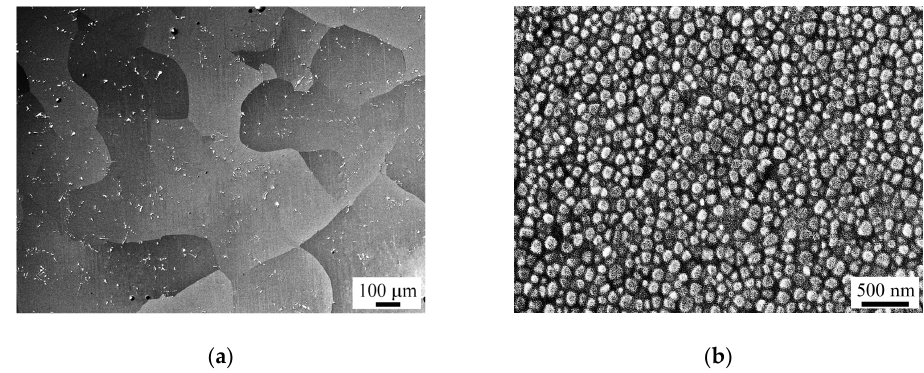
Figure 1. The back-scattering electron (BSE) images of the cast and heat treated superalloy (condition 1): ( a ) coarse γ grains and carbides (white particles); ( b ) γ ′ precipitates. Figure 2a,b represents the SE image and the EBSD orientation map obtained from the central part of the forged workpiece. Forging with intermediate annealing at subsolvus temperatures resulted in mostly recrystallized and fine-grained microstructure. There were also individual coarse γ grains with a size of 30–100 μ m. As a rule, the coarse γ grains contained low-angle boundaries (Figure 2b). The mean size of recrystallized γ grains was defined as d γ = 12 ± 1.5 μ m. The fraction of high-angle grain/interphase boundaries was defined as 80%.